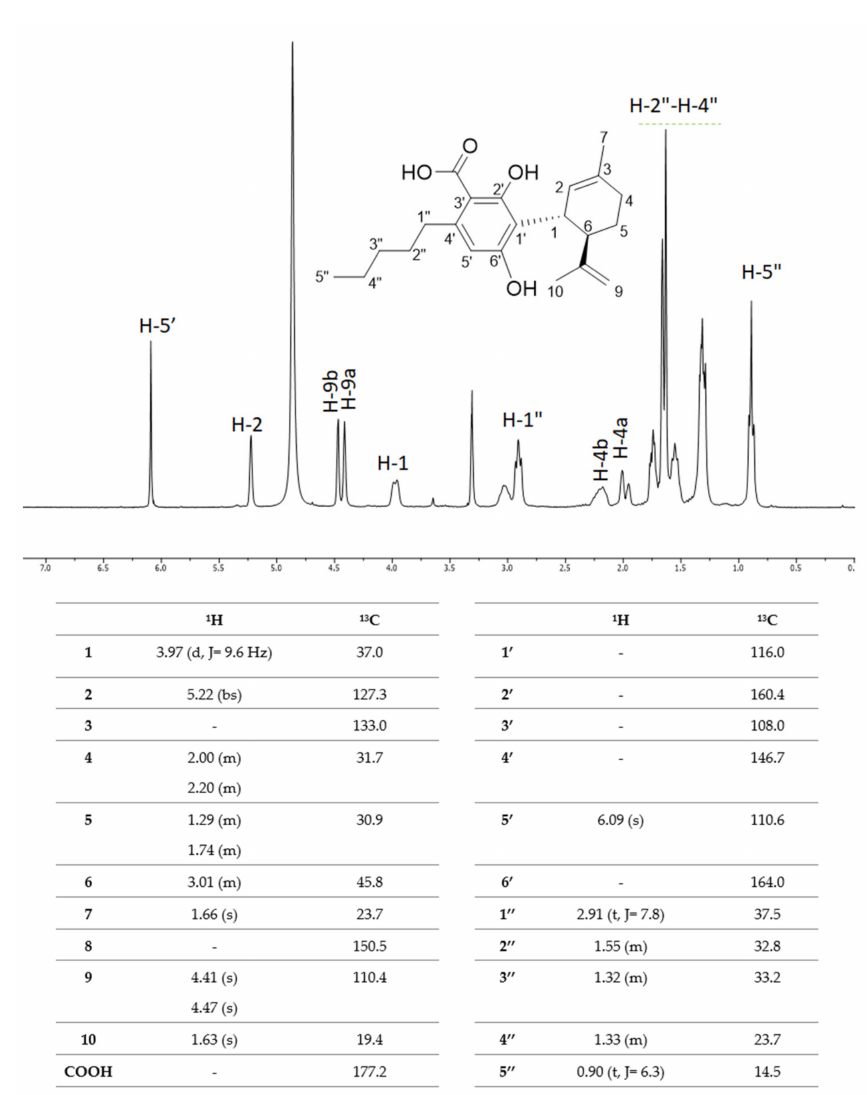
Figure 6. 1 H-NMR spectrum of CBDA. 1 H-NMR and 13 C-NMR assignments are tabulated below. NMR spectra were recorded at 300.03 MHz for 1 H and 75 MHz for 13 C on a Varian Mercury 300 spectrometer Fourier transform NMR (Varian, Palo Alto, CA, USA) in CD 3 OD at 25 ◦ C. Chemical shifts are reported in δ (ppm) and referenced to the residual solvent. J (coupling constant) are given in